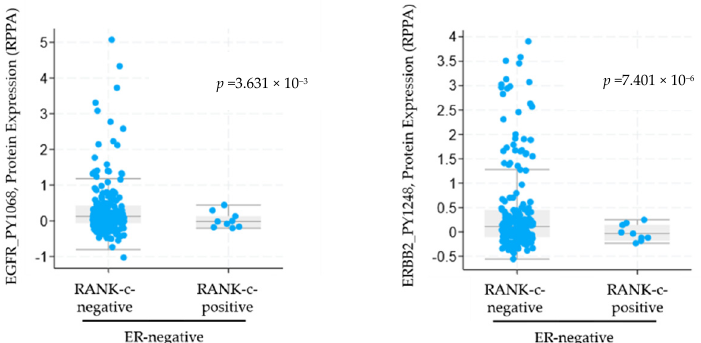
Figure 1. Analysis through the cBioPortal (cbioportal.org) for ER-negative breast cancer patients ( n = 238) for the phosphorylation levels of EGFR and ERRB2 (HER2) depending on RANK-c expres- sion. Phosphorylation of EGFR at tyrosine 1068 (left panel) and ERBB2 (HER2) at tyrosine 1248 is reduced in ER-negative samples with RANK-c expression.